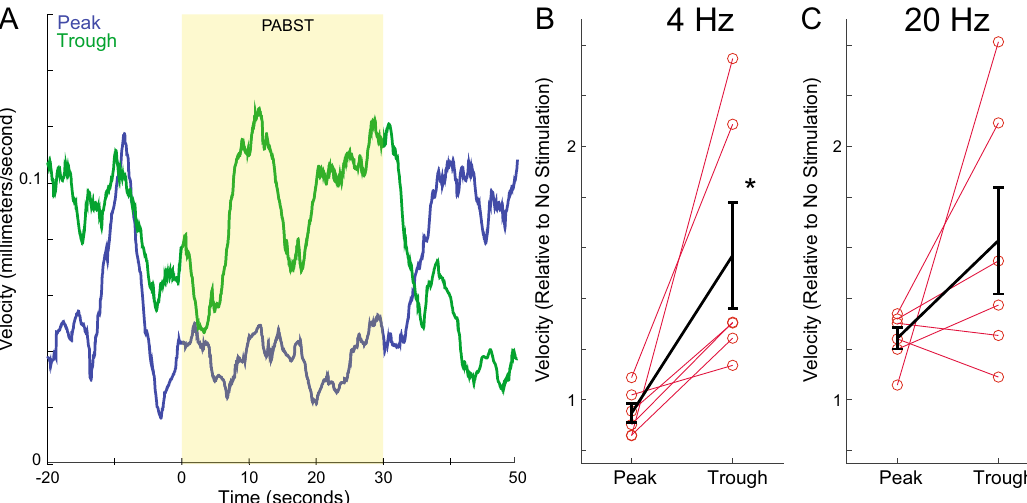
Figure 6. Closed-loop 4 Hz striatal trough stimulation improves movement velocity in dopamine-depleted mice. ( A ) We stimulated D1-expressing medium spiny neurons (D1-MSNs) at the peak or trough of 4 Hz striatal brain rhythms using PABST; example trace from one mouse from an average epoch. ( B ) We found that 4 Hz trough PABST increased head movement velocity compared to 4 Hz peak stimulation, suggesting that 4 Hz phase may be relevant to brain stimulation. ( C ) By contrast, the phase of 20 Hz rhythms did not reliably affect movement velocity. Data from six